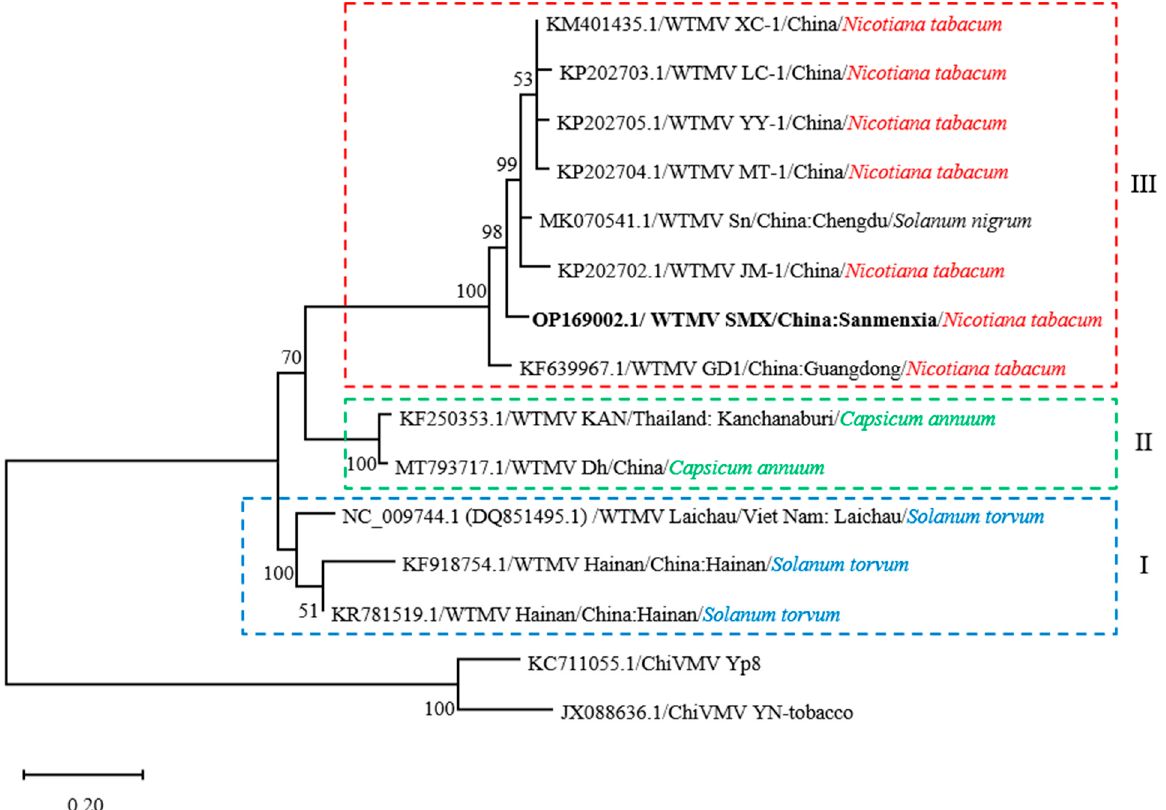
Figure 2. Phylogenetic analyses of the WTMV isolates. The evolutionary history is inferred by using the maximum-likelihood (ML) method. The full-length sequences from NCBI are used for calculations. Two chilli veinal mottle virus (ChiVMV) isolates closely related to WTMV are used as outgroups. Associated branch numbers indicate bootstrap percentages based on 100 replications. The tree is drawn to scale, with branch lengths measured in the number of substitutions per site. Isolates are labeled with Genbank accession numbers, locations, and hosts. The groups based on the phylogeny are emphasized with colored, dashed rectangles.